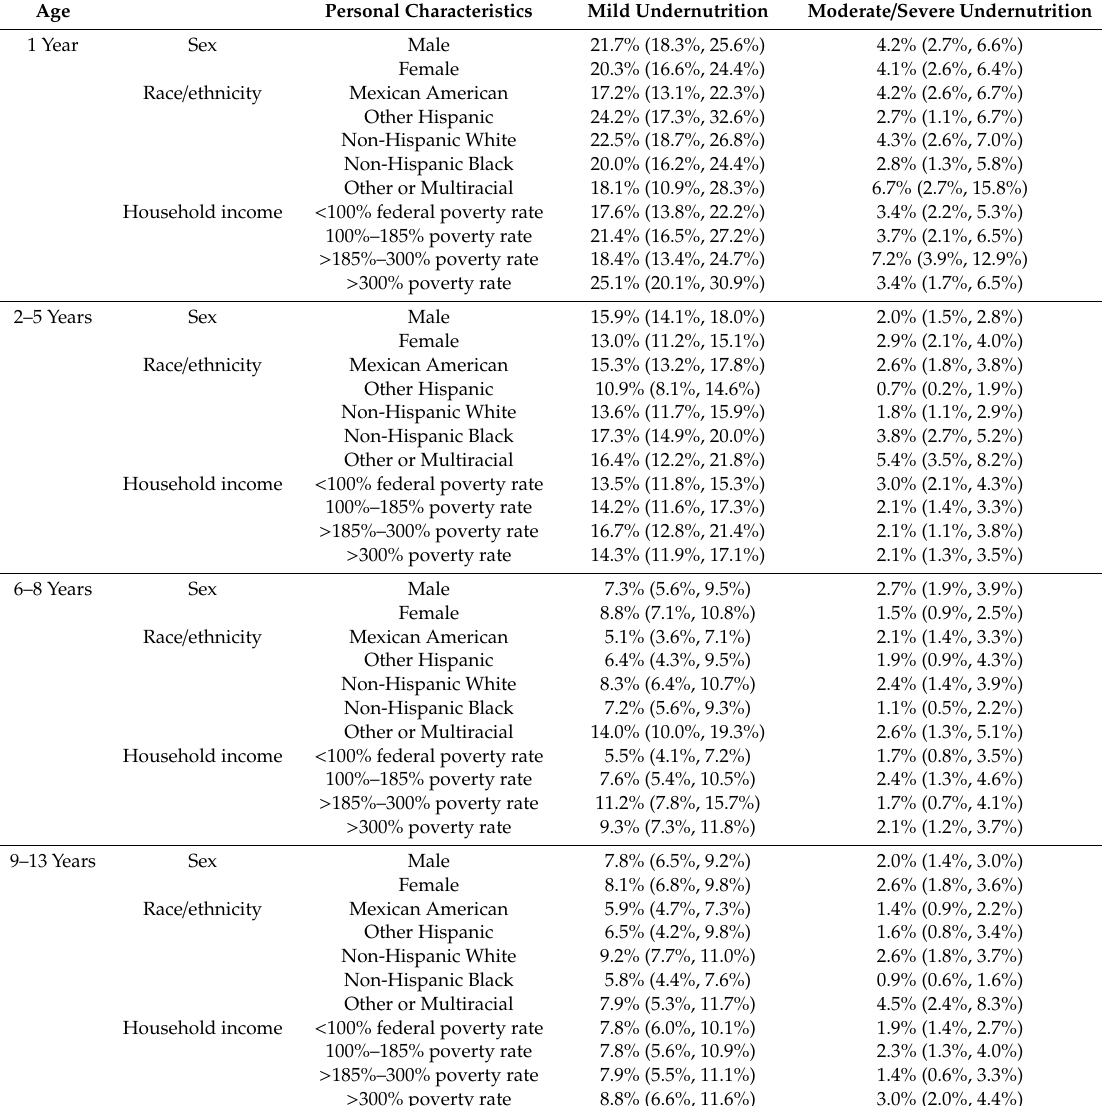
Table 4. Prevalence of pediatric undernutrition by sociodemographic characteristics and age categories in US children from NHANES 2005–2014 data ( n =